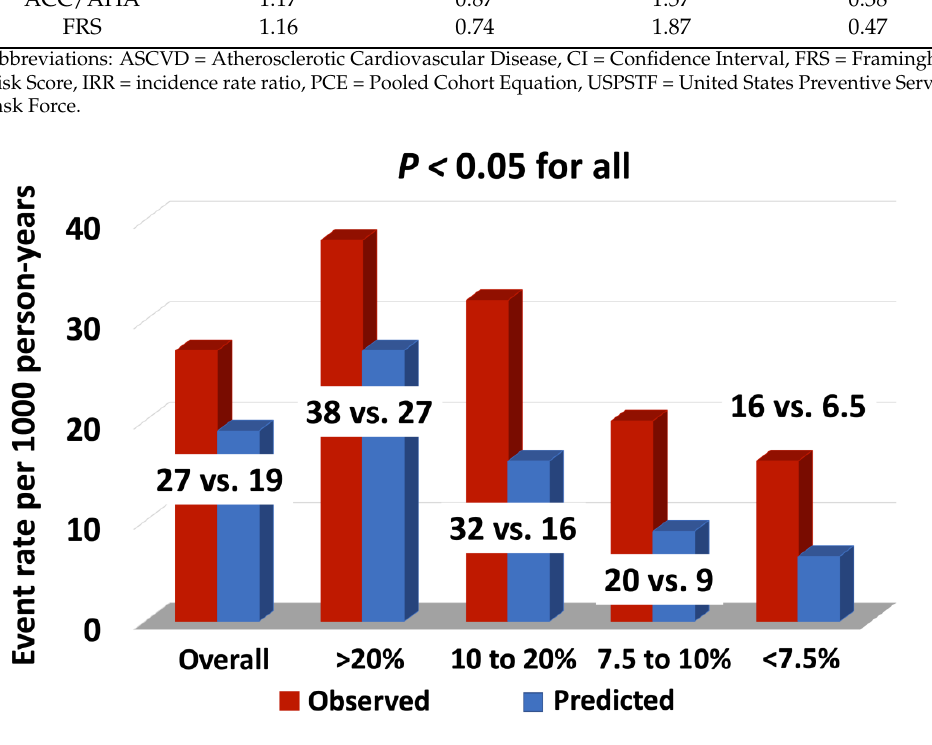
Abbreviations: ASCVD = Atherosclerotic Cardiovascular Disease, FRS = Framingham Risk Score, PCE = Pooled Cohort Equation, USPSTF = United States Preventive Services Task Force. Table 7. Poisson regression analysis, outcome—ASCVD event. Table 6. Competing risk model (Fine–Grey Model), outcome—ASCVD event. ASCVD Criteria